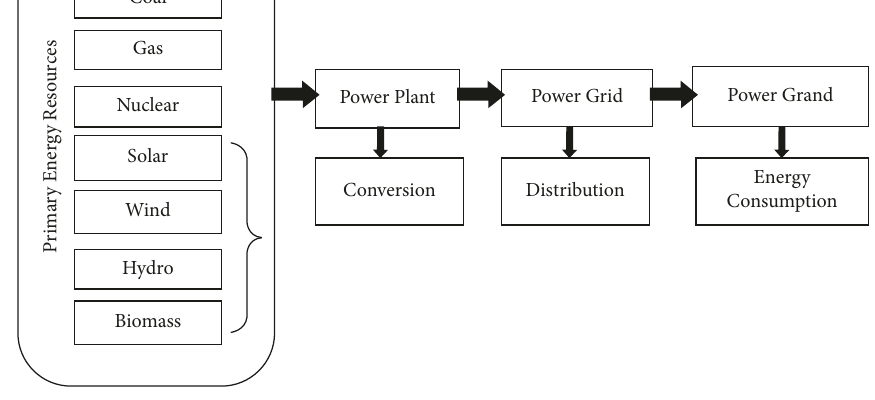
Figure 2: Energy generation forecast model.